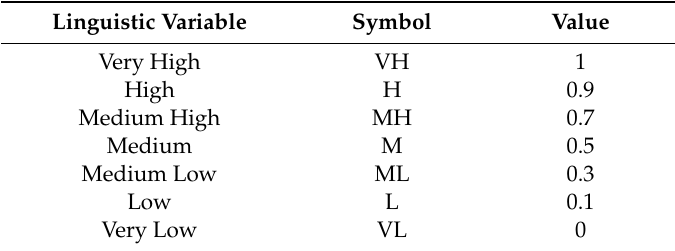
Table 5. Linguistic